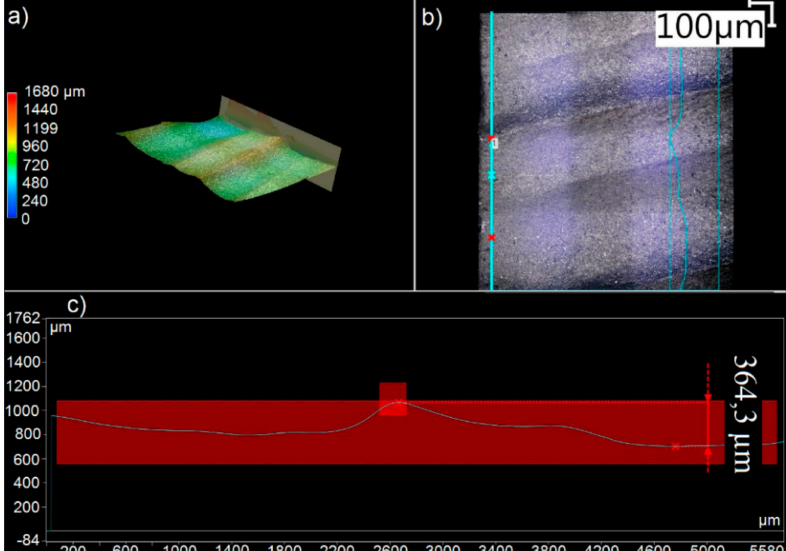
Figure 4. Example of a microscopic examination report of the measurement of irregularities in the jet exit region at lower specimen edge (m a = 50%, v f = 80 mm/min): ( a ) 2D view, ( b ) 3D view, and ( c ) typical surface irregularity